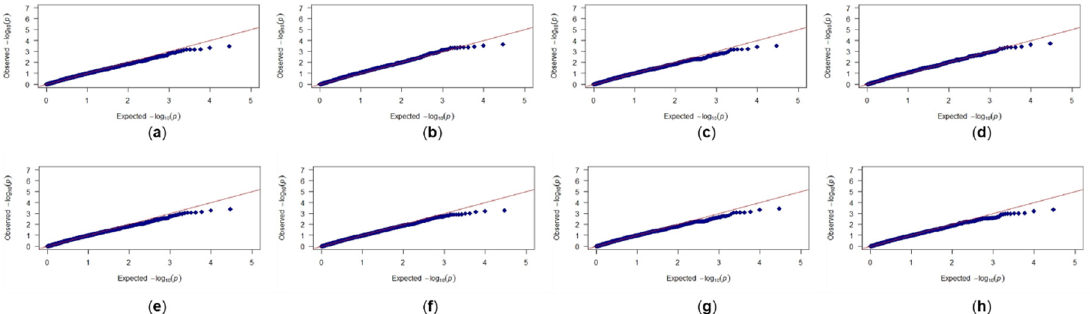
Figure 5. Quantile-quantile plots for water retention capacity trait: ( a ) GLM model with no covariates; ( b ) GLM model with bran yield (BY) as covariate; ( c ) GLM model with bran friability (BF) as covariate; ( d ) GLM model with BY and BF as covariates; ( e ) MLM model with kinship and no covariates; ( f ) MLM model with kinship and BY as covariate; ( g ) MLM model with kinship and BF as covariate; ( h ) MLM model with kinship and BY and BF as covariates.